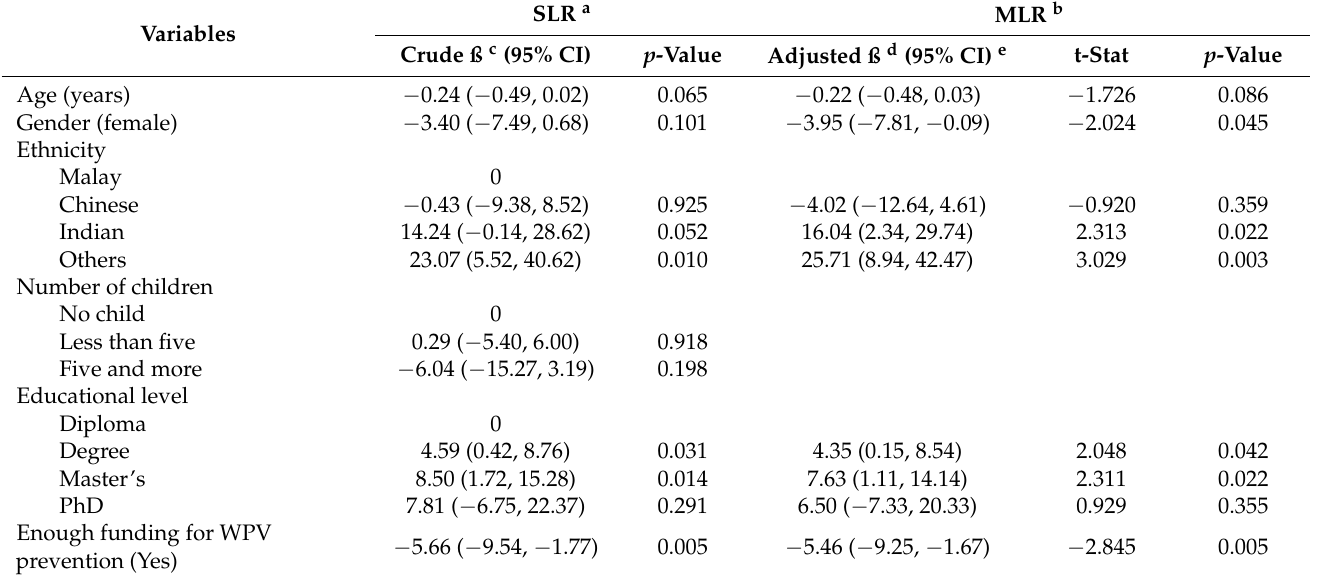
Table 6. Factors associated with perception towards WPV prevention among employers at healthcare facilities in Melaka ( n =